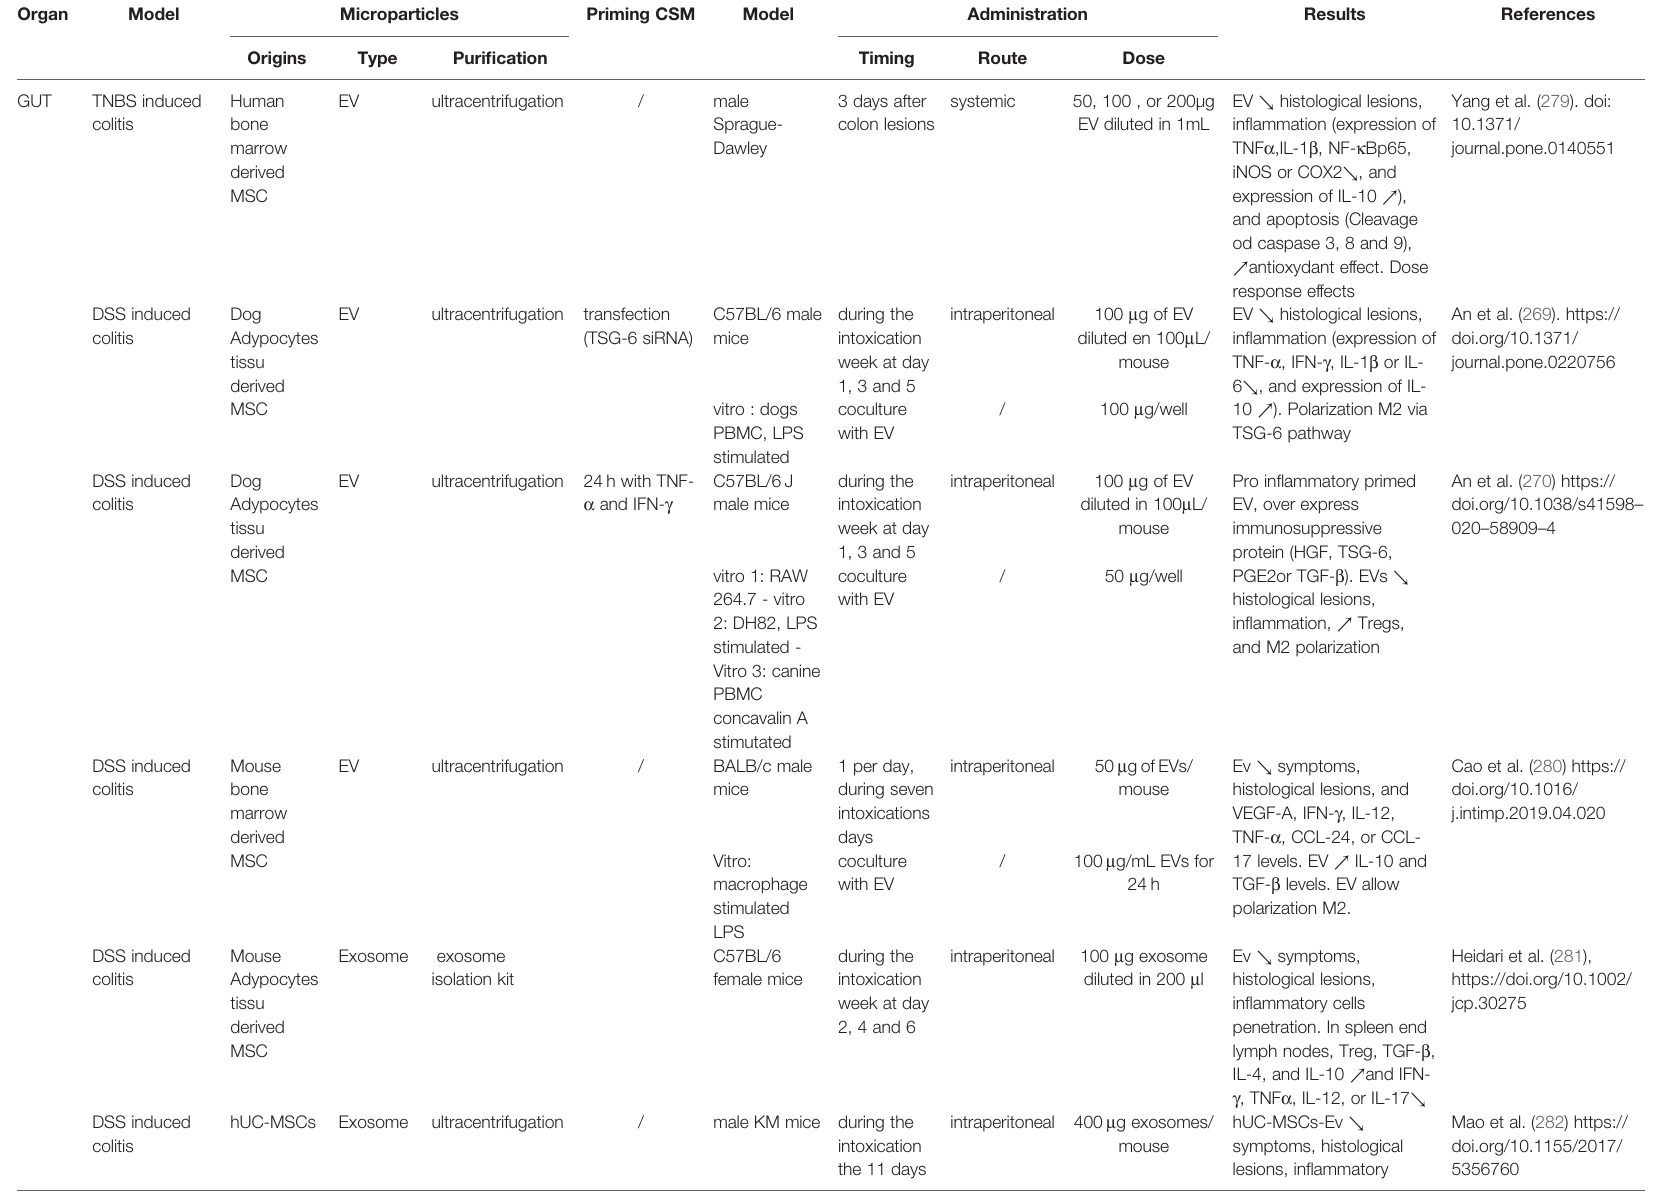
TABLE 1 | Overview of the applications of mesenchymal stromal cell-derived extracellular vesicles (MSC-EVs) in preclinical experimental